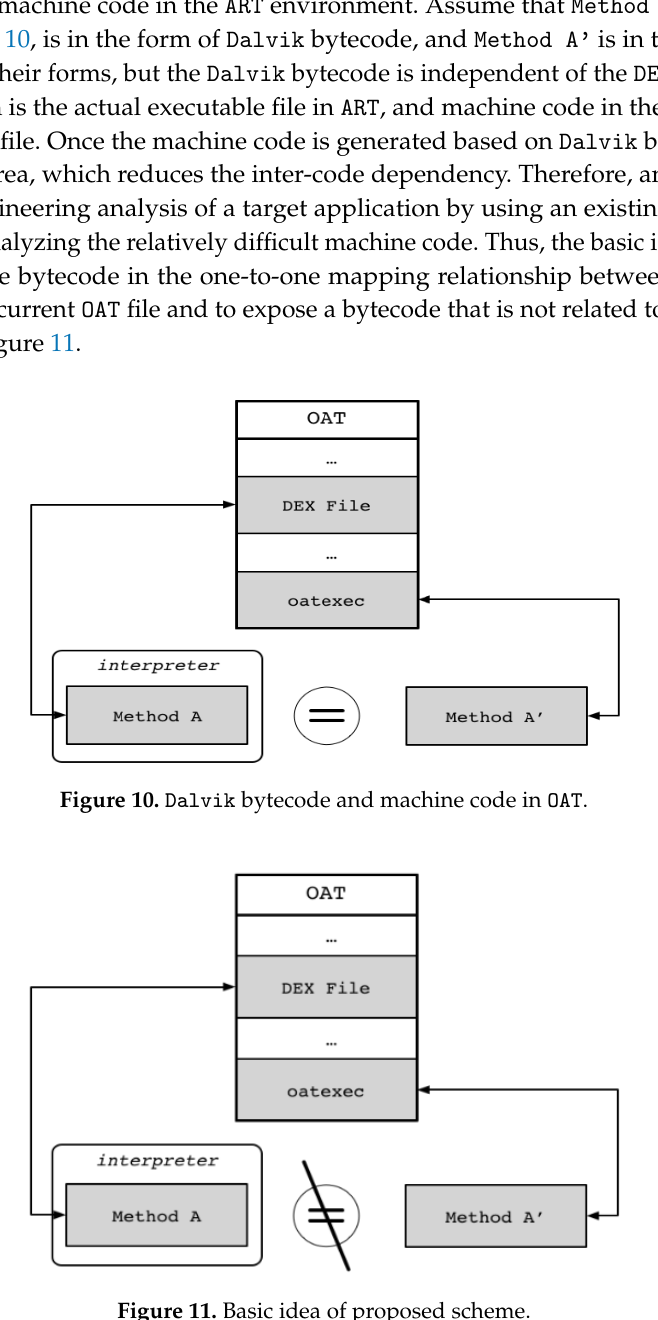
Figure 11. Basic idea of proposed